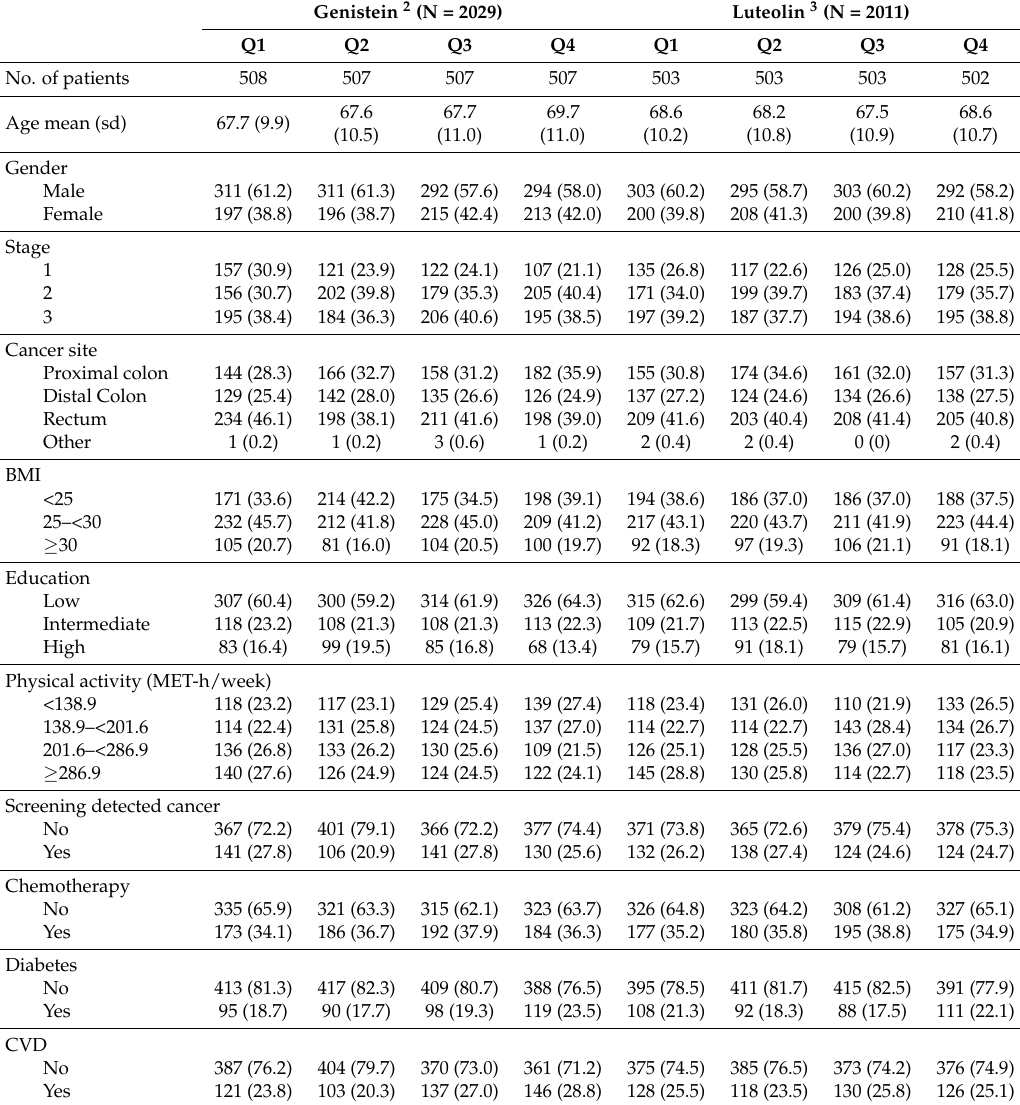
Table 1. Characteristics of CRC patients by quartiles of serum genistein and luteolin concentrations 1